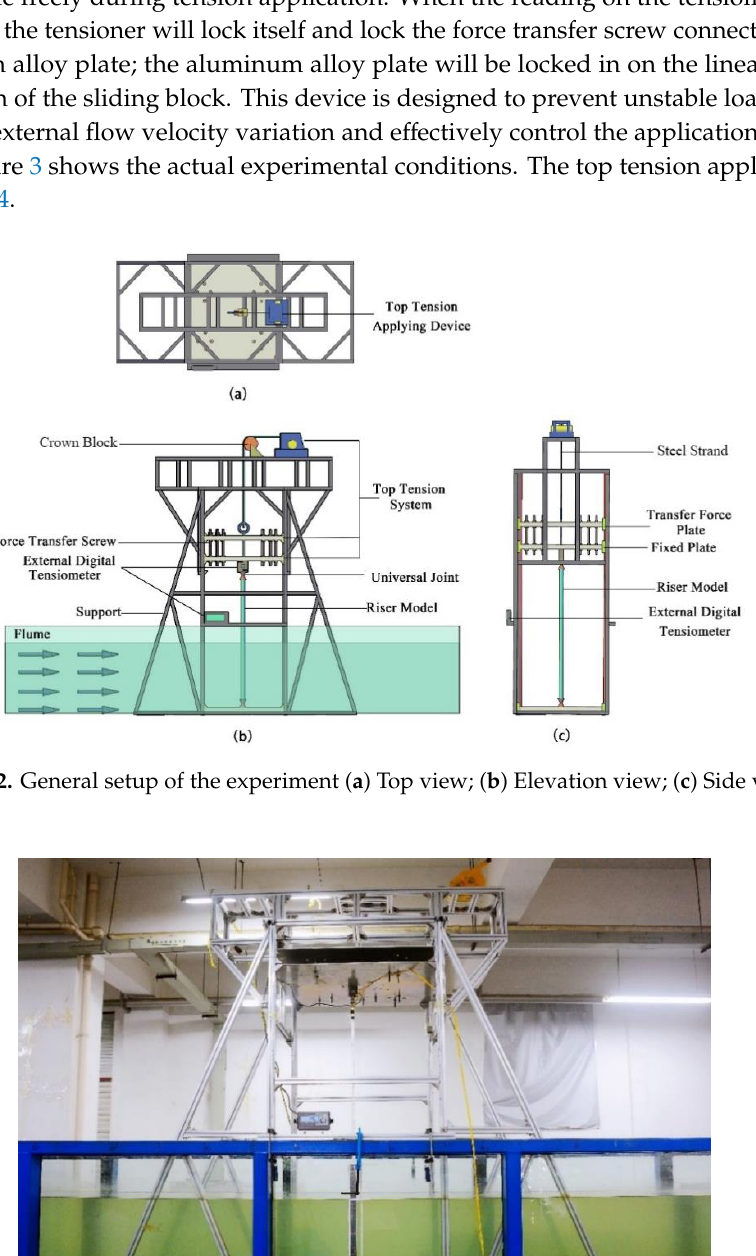
Figure 3. Actual working conditions of installation and launching of riser and supporting structure.